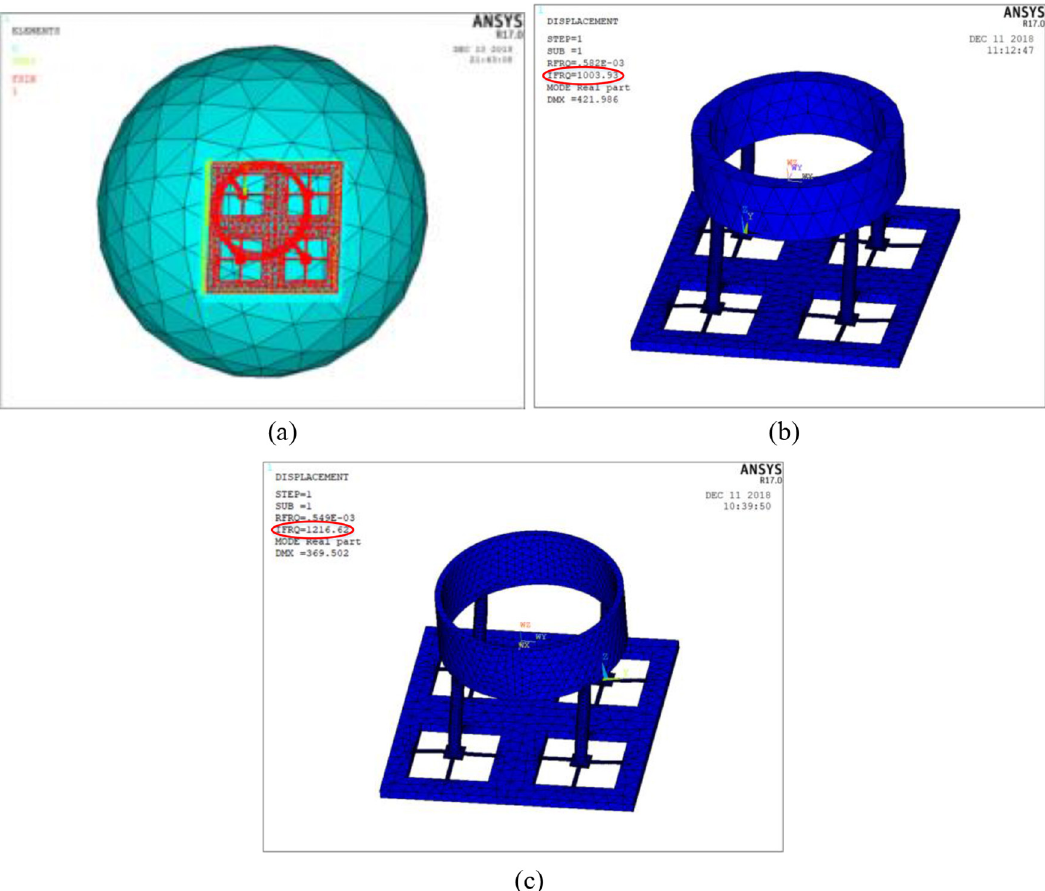
Fig. 12. The analysis of FSI. (a) Fluid-solid coupling interface (b) AFUVH basic model (c) AFUVH optimized